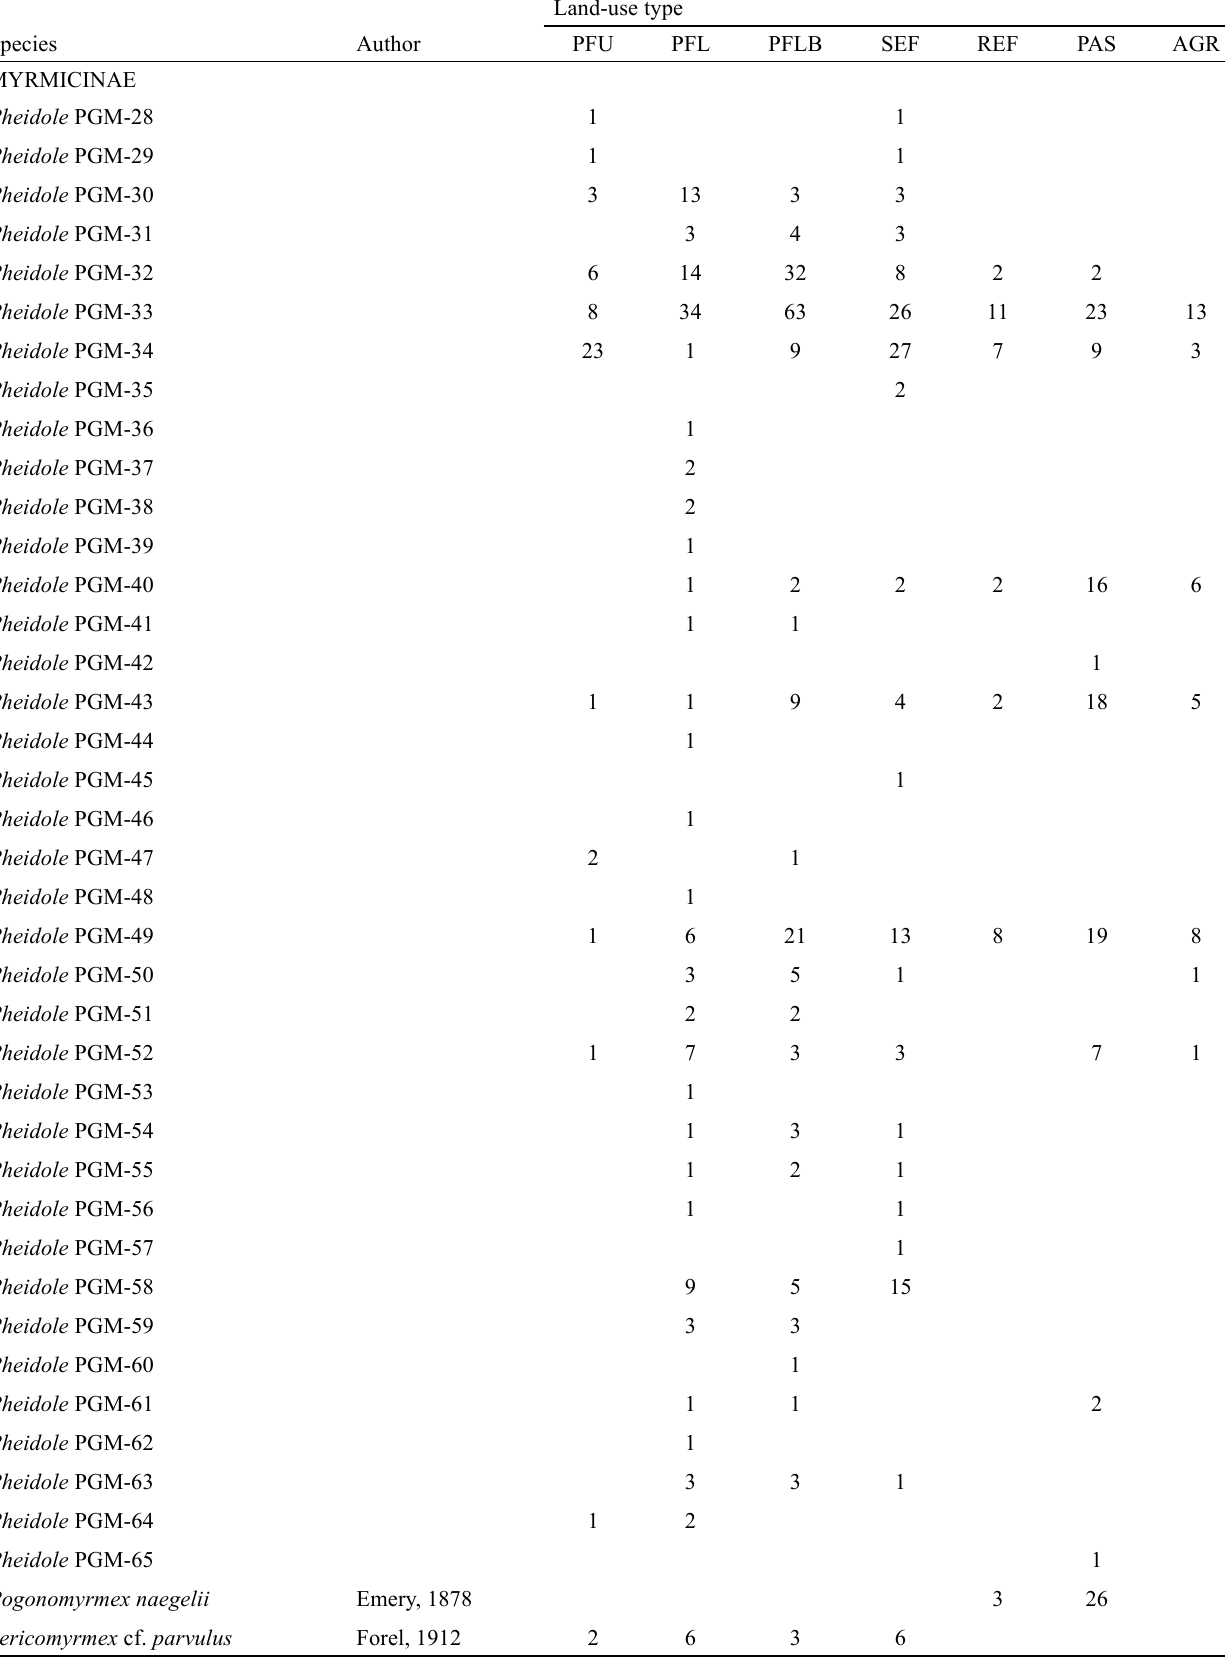
Table 2 . List of ant species collected in this study. Values represent number of records per pitfall traps of each species in each land-use type: PFU – primary forest undisturbed, PFL – primary forest logged, PFLB – primary forest logged and burnt, SEF – secondary forest, REF – reforestation with commercial species, PAS – pasture, AGR – agricultural areas.